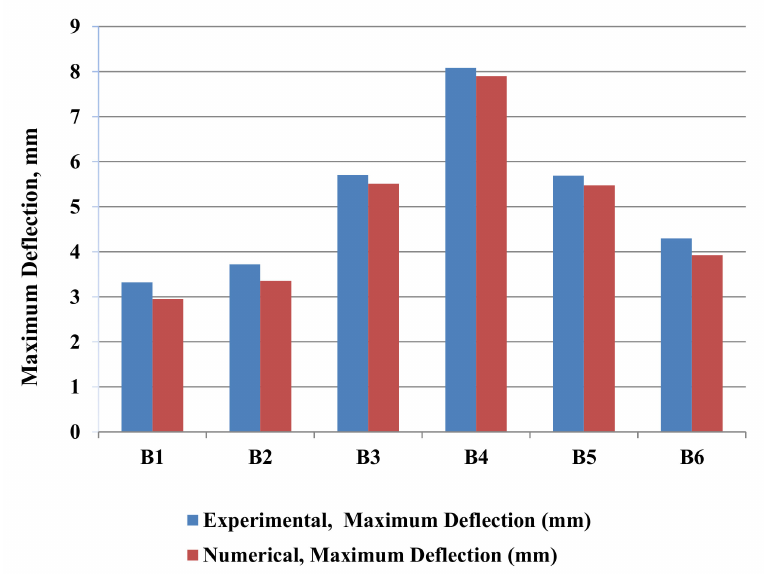
Figure 17. Comparisons of the numerical and experimental results of the maximum deflections at mid-span for all the RC beam